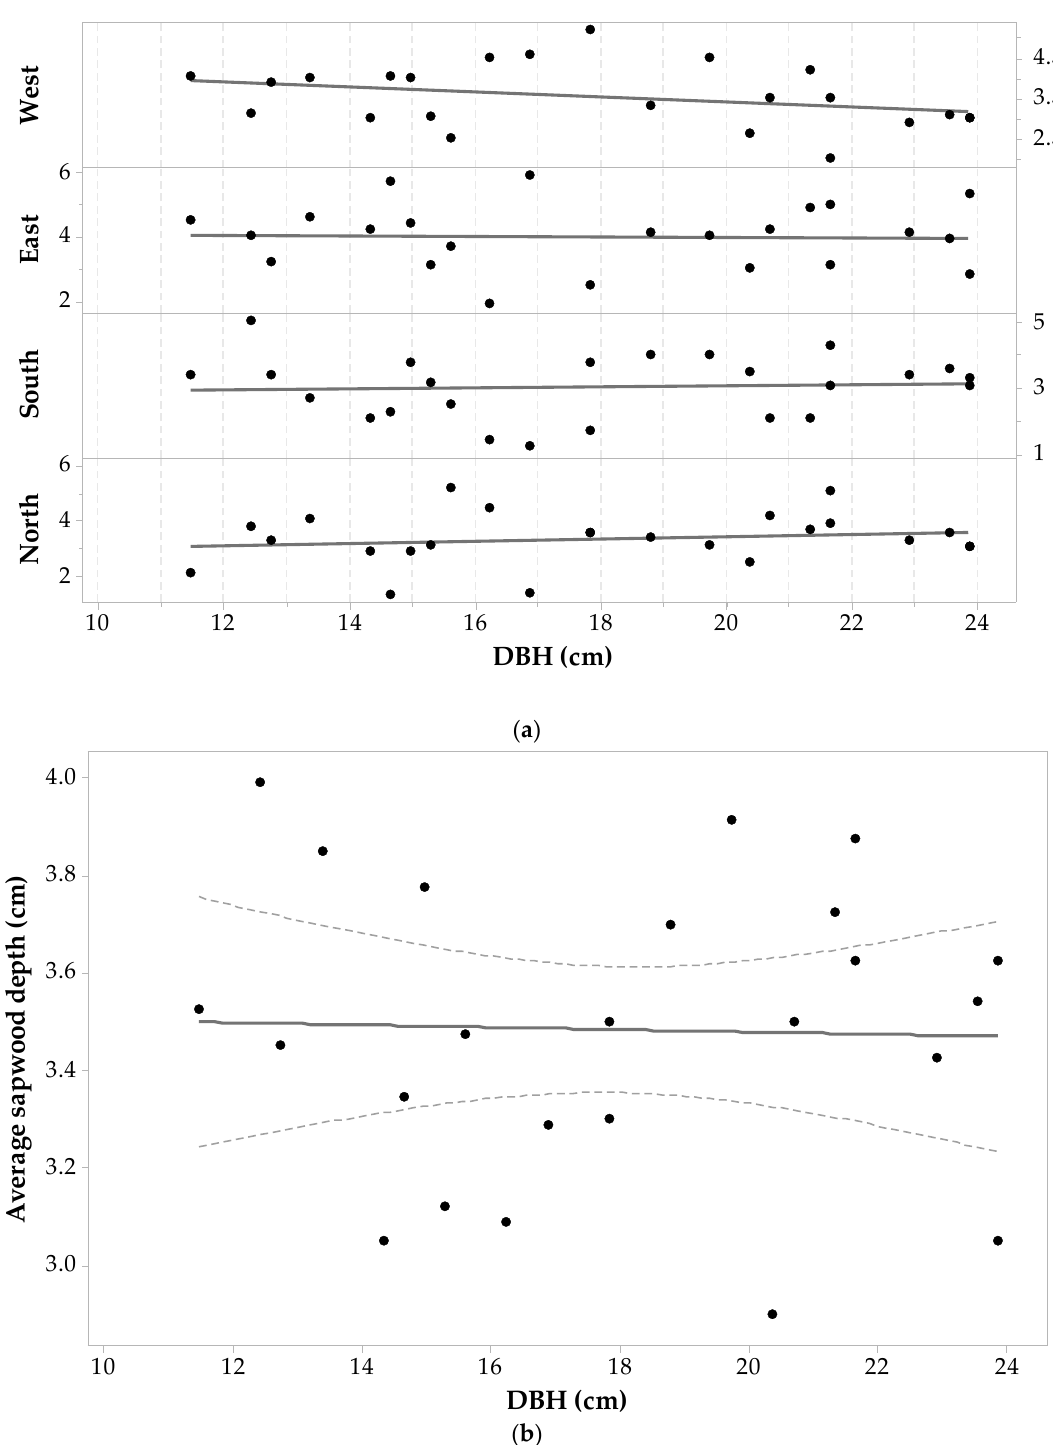
Figure 4. Pinus banksiana ( a ) sapwood depth (cm) at each cardinal point for each tree versus diameter at breast height ( DBH ); and ( b ) average sapwood depth (points) with 95% confidence intervals (dashed lines) and a fitted linear regression model (solid line).